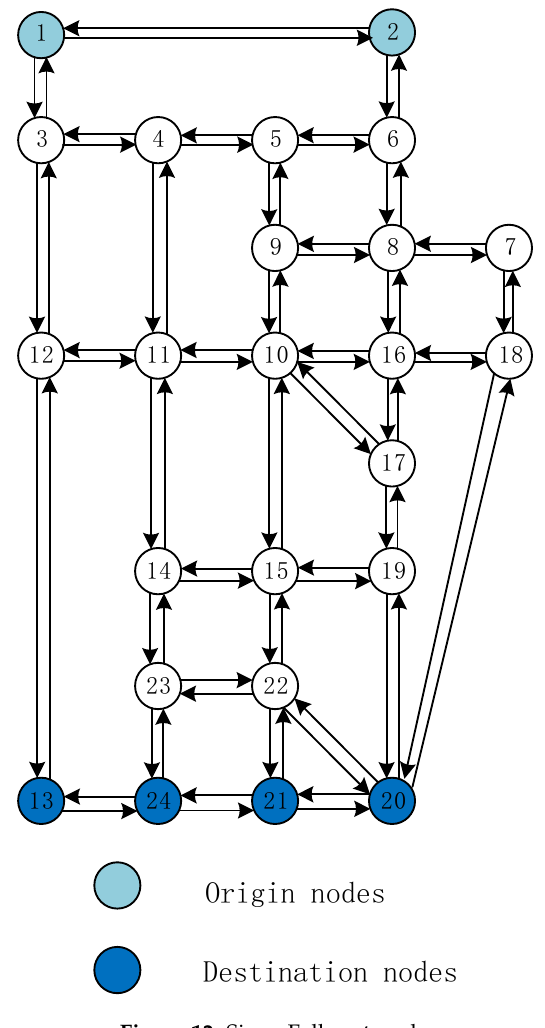
Figure 12. Sioux Falls network.